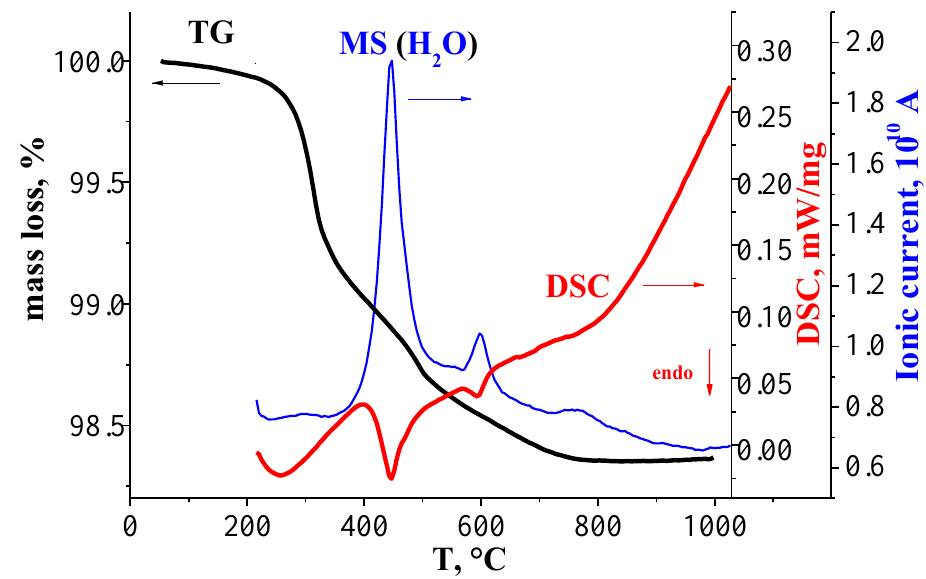
Figure 3. TG-(dark line), DSC-(blue line), and MS (H 2 O)-data (red line) for hydrated sample BaLaInO 4 ∙ n H 2 O.